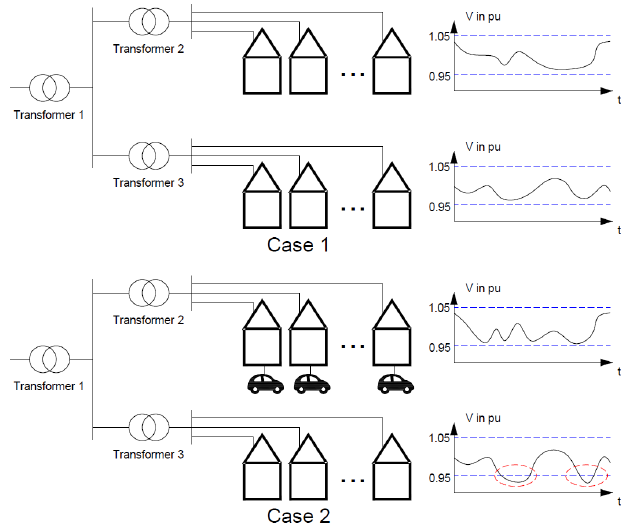
Figure 1. Example of voltage profiles on the distribution transformers for two cases.